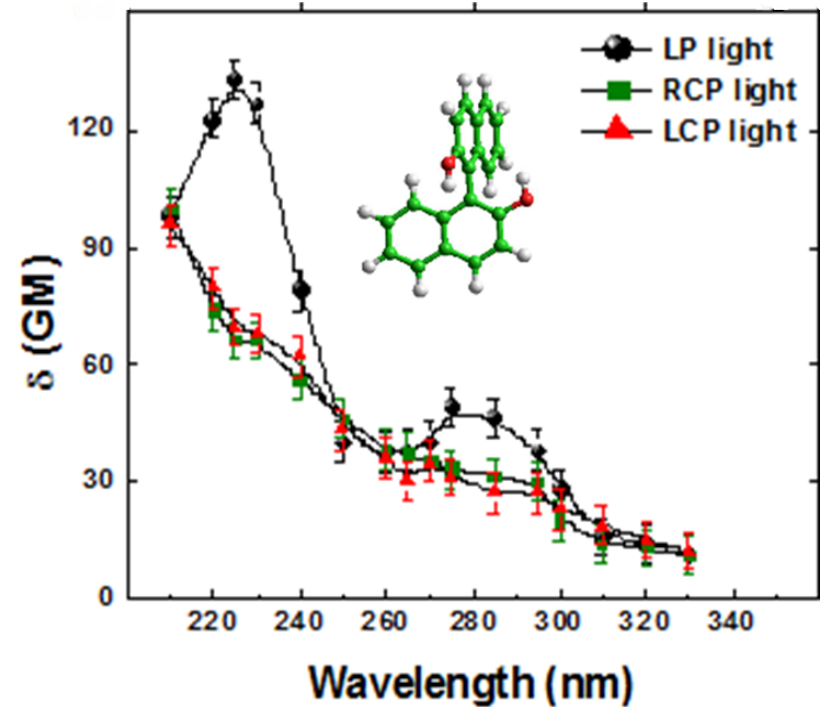
Figure 2. Single beam Z-scan TPA spectra of R -BINOL/THF pumping with RCPL (green solid squares), LCPL (red solid triangles) and LPL (black solid circles) and display at half of the excitation